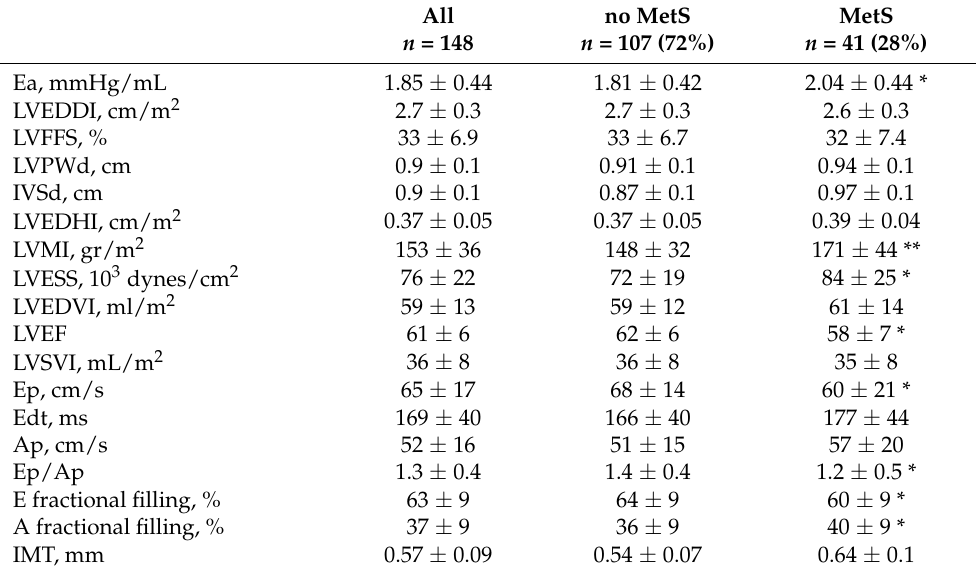
Table 2. Echocardiographic and vascular ultrasound variables in all subjects (All), subjects without metabolic syndrome (no MetS), and with MetS (MetS).